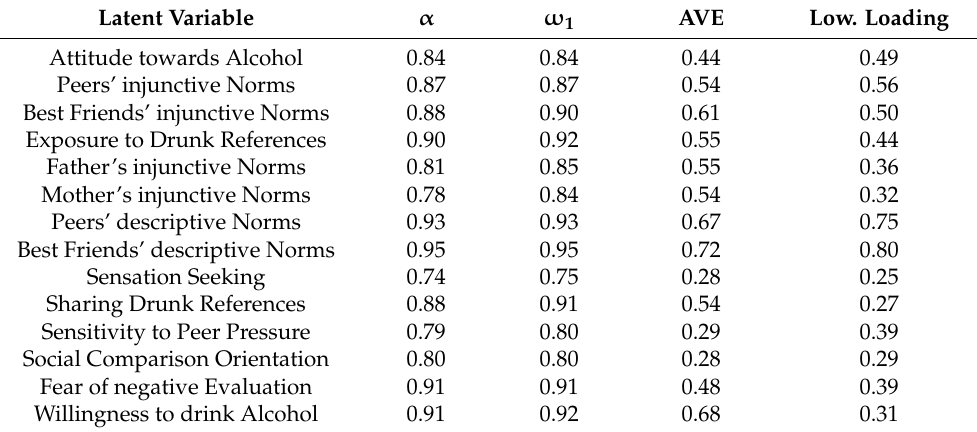
Table 1. Reliability